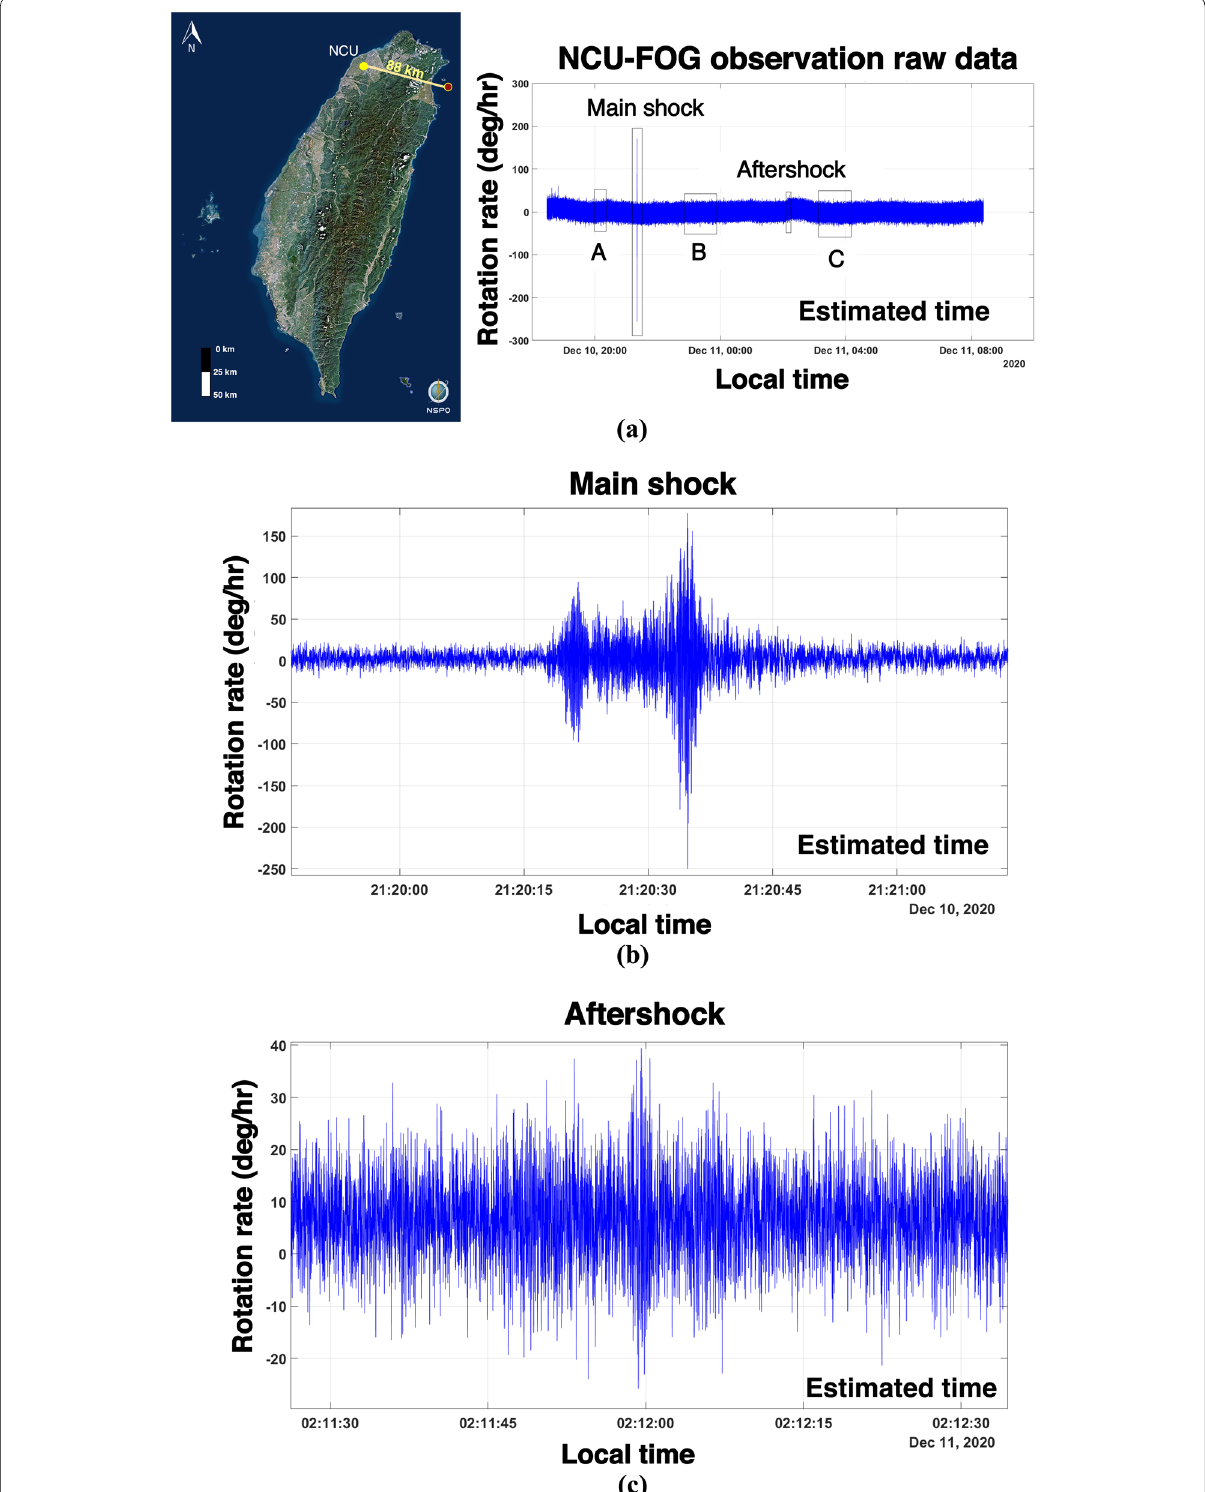
Fig. 2 a (Left) The seismic wave observation location (at NCU) with respect to the location of the M6.6 Yilan earthquake. (Right) 14‑h unfiltered seismic‑wave monitoring raw data with the NCU‑FOG sensor. b and c FOG response of the rational component of the seismic waves monitored during the time periods of the main shock and the aftershock events,